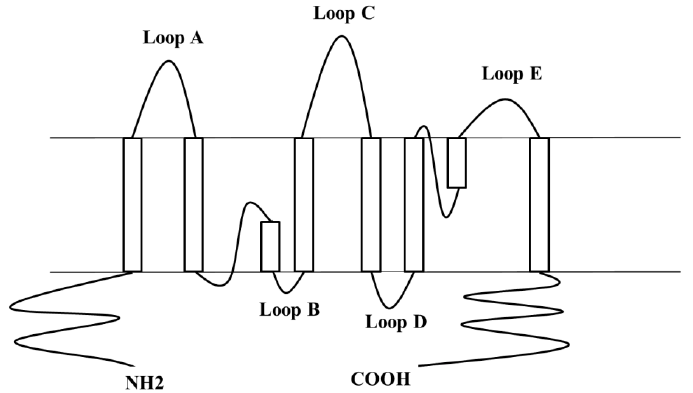
Figure 1. 2D sketch of human aquaporin-4 (hAQP4) structural elements. hAQP4 is made of eight membrane-embedded helical segments, three extracellular loops ( loop A , loop C and loop E ) and two intracellular loops ( loop B and loop D ). Adapted from reference [22].